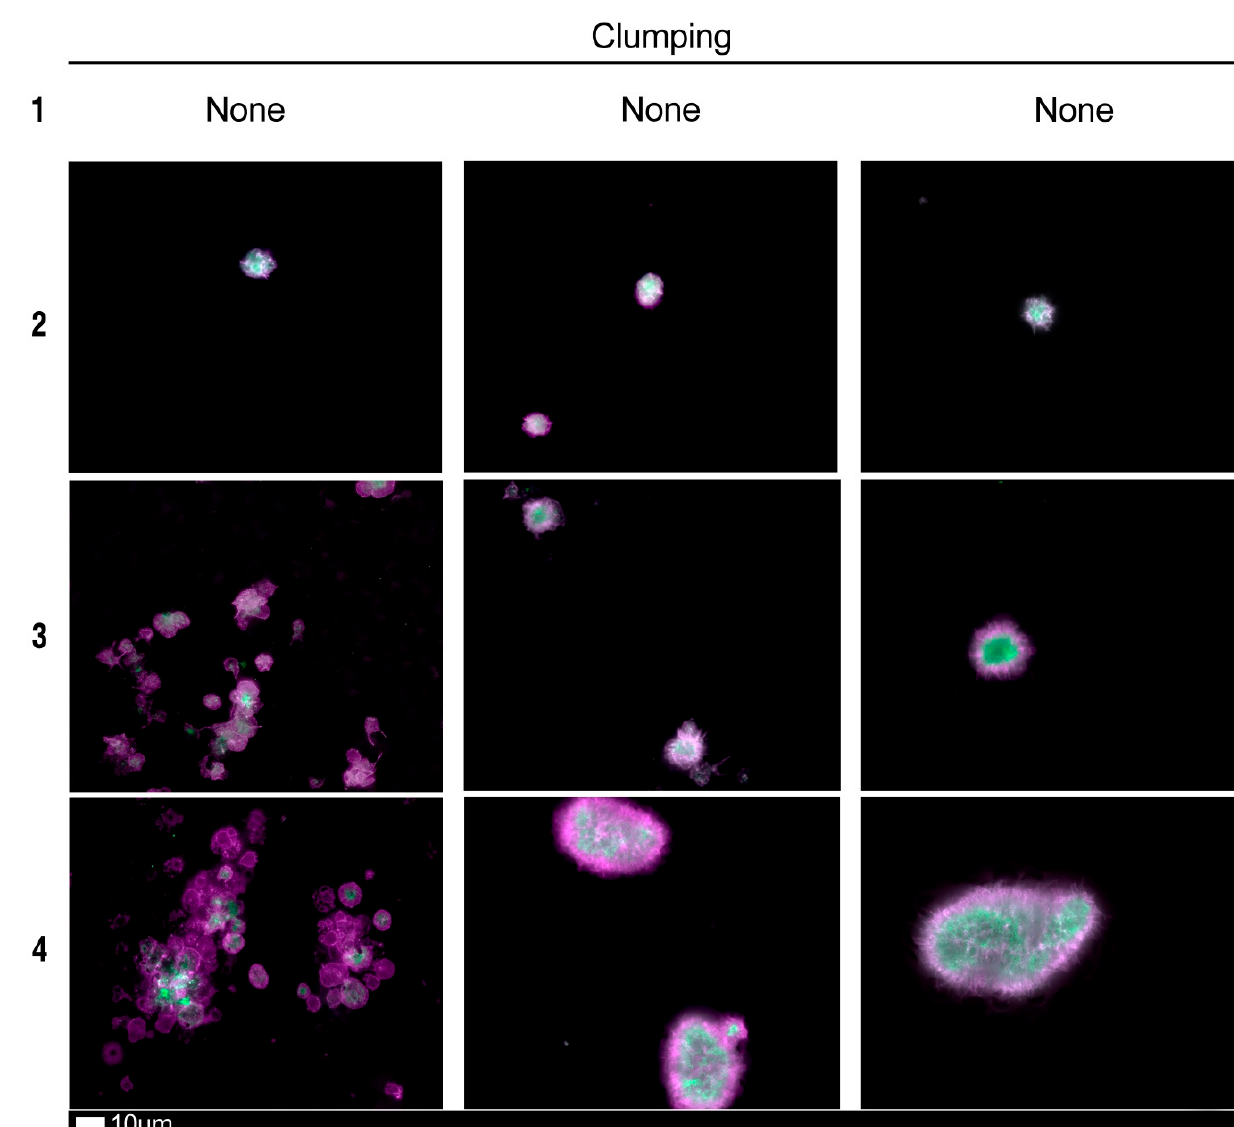
Figure 6. Fluorescence microscopy examples of the different stages of platelet clumping. With no clumping occurring in the healthy/control samples in Stage 1 (no figures shown), progressing to severe clumping of platelets as seen in Stage 4. Stage 1 to 4 is also used as a numerical scoring system, where a score of 1 is given for no clumping and a score of 4 is given for severe clumping. Table 3. Platelet activation criteria showing level of spreading, as well as clumping in the hematocrit sample. Score